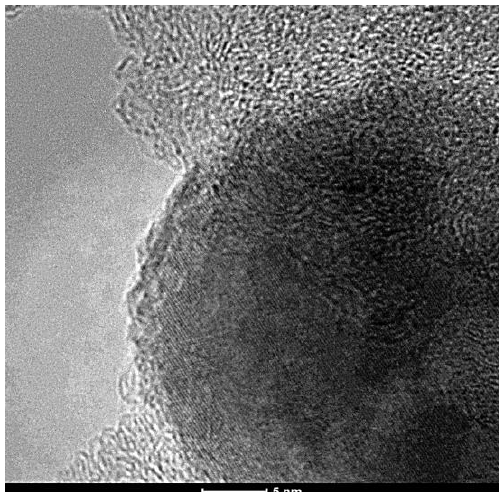
Figure 3. The TEM micrograph of a nickel particle from which a carbon nanofilament was